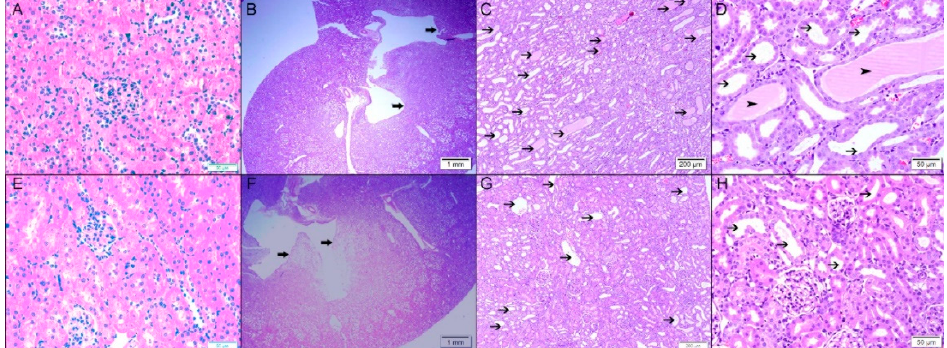
Figure 6. Histological features in the right nonobstructed and left obstructed kidneys after three days of left UUO in both Vx ‐ 1 and AG ‐ 1. Upper panel (Vx ‐ 1): ( A ), right kidney: normal kidney architecture and histology with no dilated tubules and normal calices; ( B ), left kidney with large areas of tubular dilatation in cortex, medulla, collecting ducts in renal papillary area, and dilated calices (thick arrow); ( C , D ), large areas of dilated tubules in cortex and medulla (thin arrow) with protein secretion in some of them (arrow head). Lower panel (AG ‐ 1): ( E ), right kidney: normal kidney architecture and histology with no dilated tubules and normal calices; ( F ), left kidney showing variable areas of tubular dilatation in cortex, medulla, collecting ducts in renal papillary area with dilated calices (thick arrow). ( G , H ), showing areas of dilated tubules in cortex and medulla (thin arrow) but less marked than the AG ‐ 1.